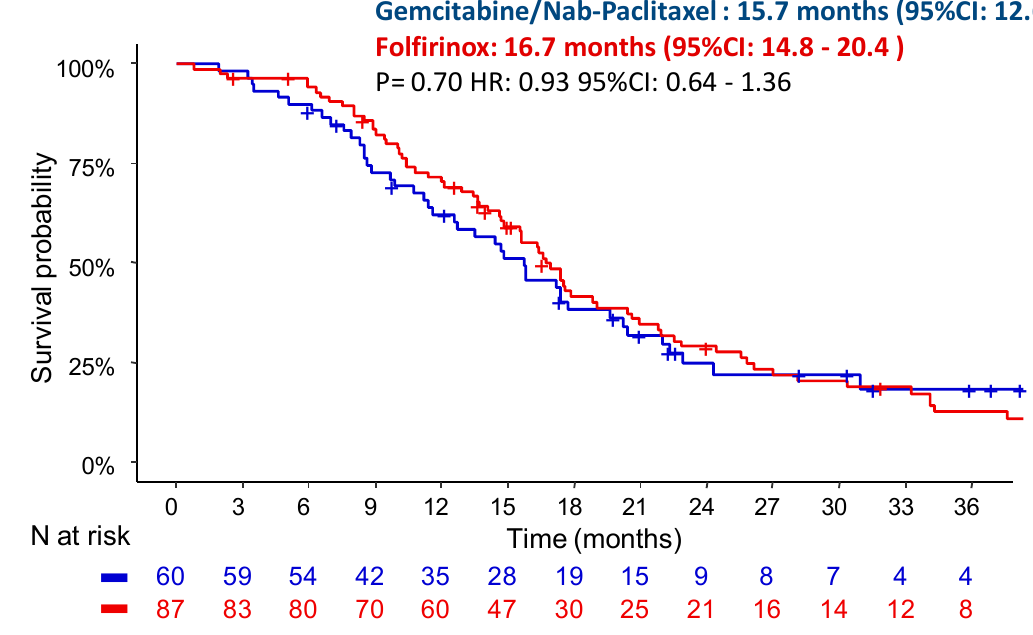
Figure 2. Overall survival depending on the chemotherapy regimen in patients with locally advanced pancreatic cancer.